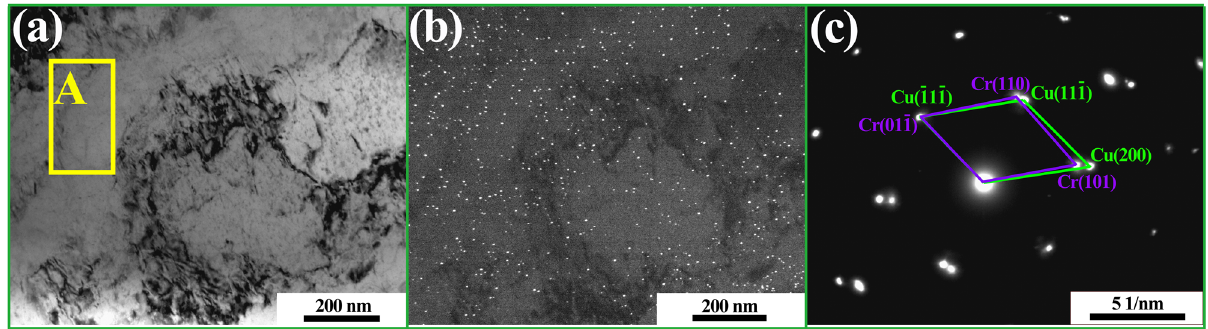
Figure 9: TEM images of Cu – Cr – Ti alloy after the ST + 80% + aging treatment: ( a ) bright fi eld image; ( b ) dark fi eld image; ( c ) SAED pattern of the area A in ( a ) .